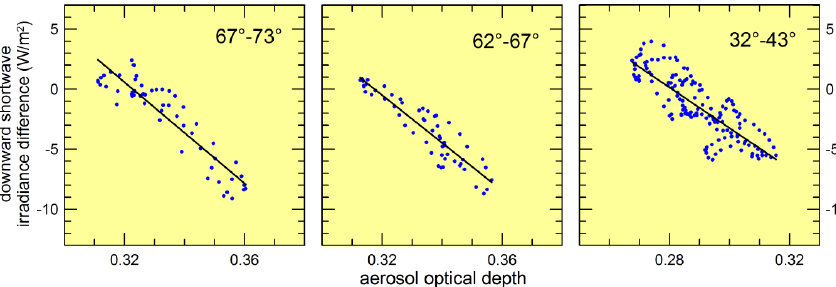
Fig. 4. Deviations of the measured downward shortwave irradiance at fixed column water 619 vapour from the estimated irradiance at fixed water vapour and aerosol optical depth 620 versus the measured aerosol optical depth, for three intervals of solar zenith angle. 621 622